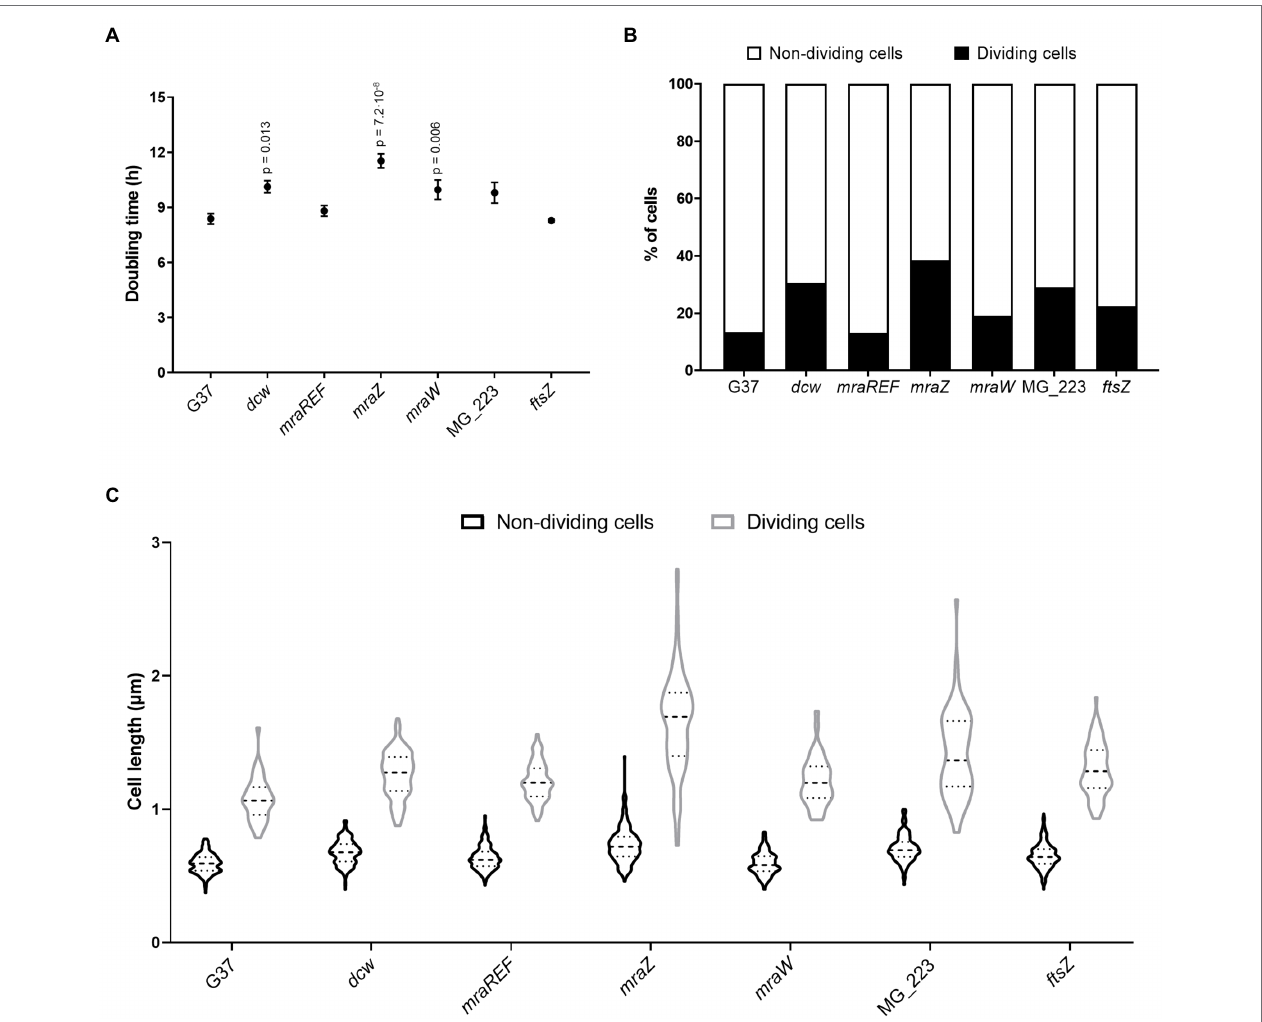
FIGURE 2 | Cell fitness analysis of the wild-type strain and several M. genitalium mutants. Growth rates (A) and percentage of cells in division (B) of different M. genitalium mutants of the cell division gene cluster. Statistical significance was assessed using the Student’s t -test and the value of p of significant values ( p < 0.05) is indicated above each data point. An average of 900 cells for each strain were analyzed (C) . Graph depicting the length of single or cytokinetic cells. An average of 320 cells for each strain were